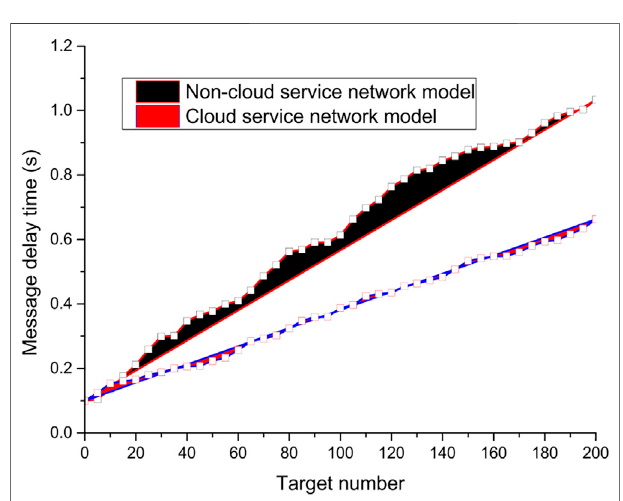
FIGURE 10 | Message delay analysis and